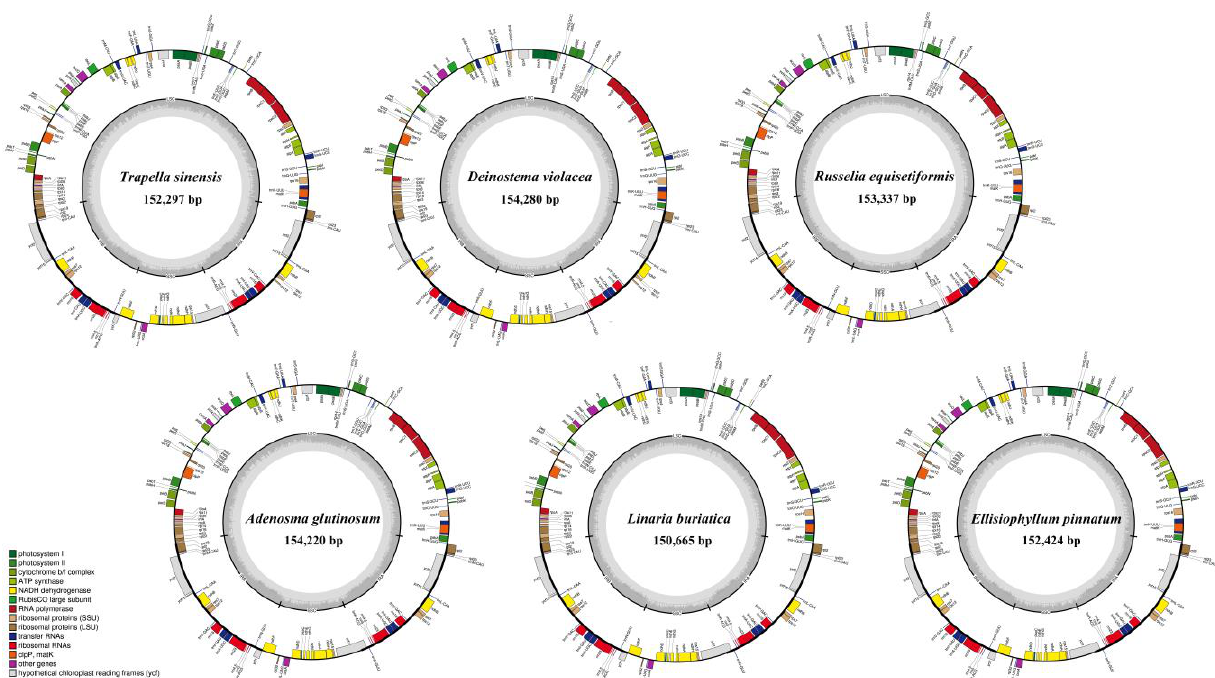
Figure 1. Circular maps of six Plantaginaceae plastomes. Genes shown outside of the outer layer circle are transcribed clockwise, whereas those insides are transcribed counterclockwise. The genes belonging to different functional groups are color-coded. The darker gray area of the inner circle denotes the GC content, while the lighter gray area indicates the AT content of the genome. LSC, large single-copy; SSC, small single-copy; IR, inverted repeat.